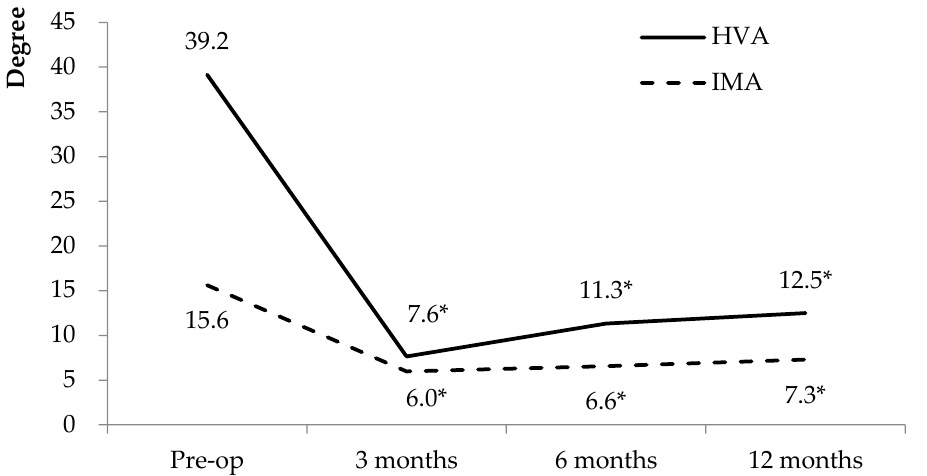
Figure 3. Radiographic outcomes. * Compared with baseline parameters, p < 0.001. HVA: hallux valgus angle, IMA: intermetatarsal angle.